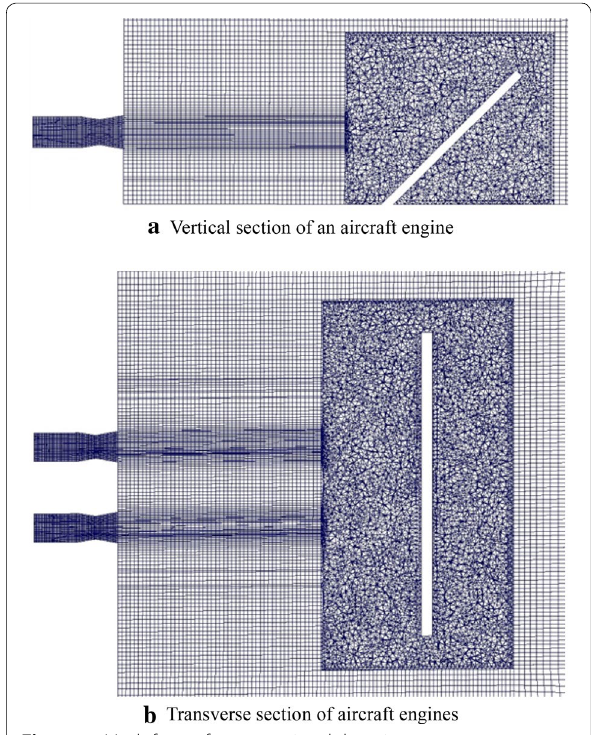
Figure 4 Mesh form of computational